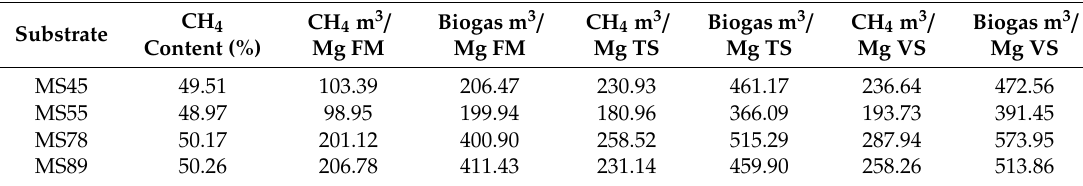
Table 2. The biogas and methane production from tested